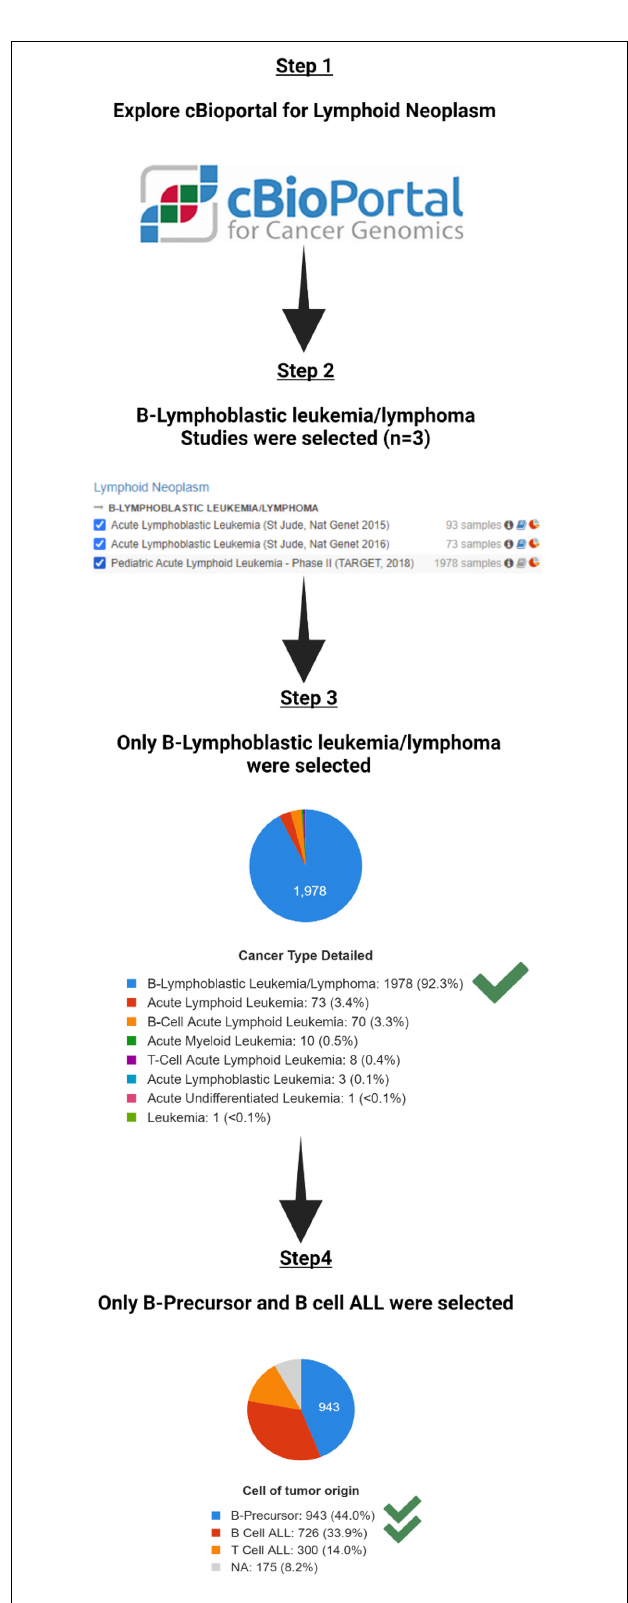
FIGURE 1 | The flowchart for the studies and samples selected for the analysis.